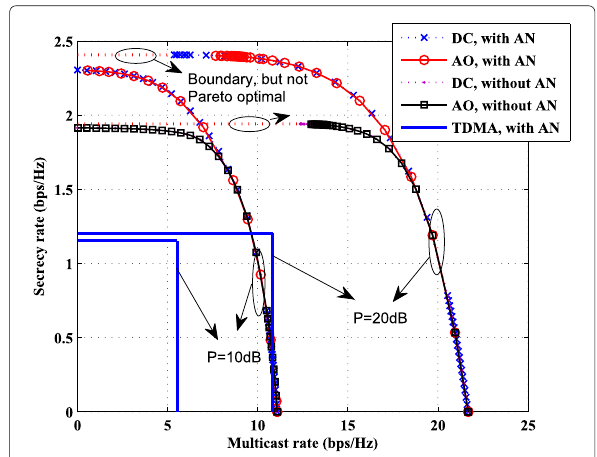
Fig. 5 Secrecy rate regions with and without AN (Config 2)